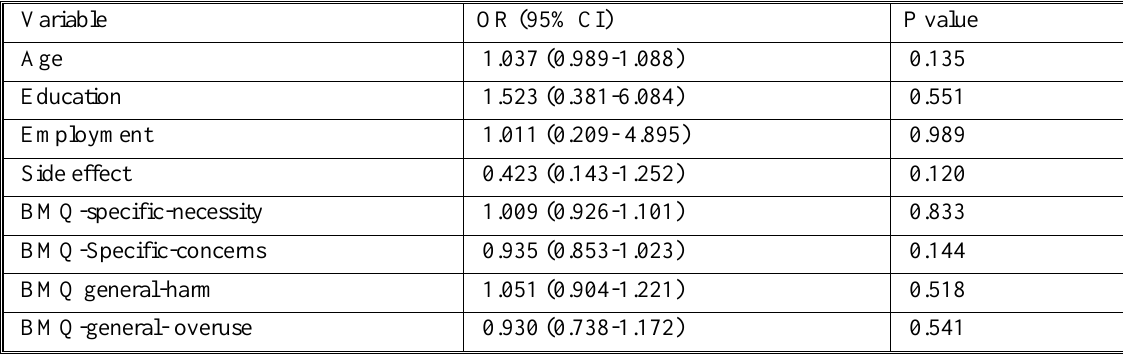
Table 5. Factors predicting